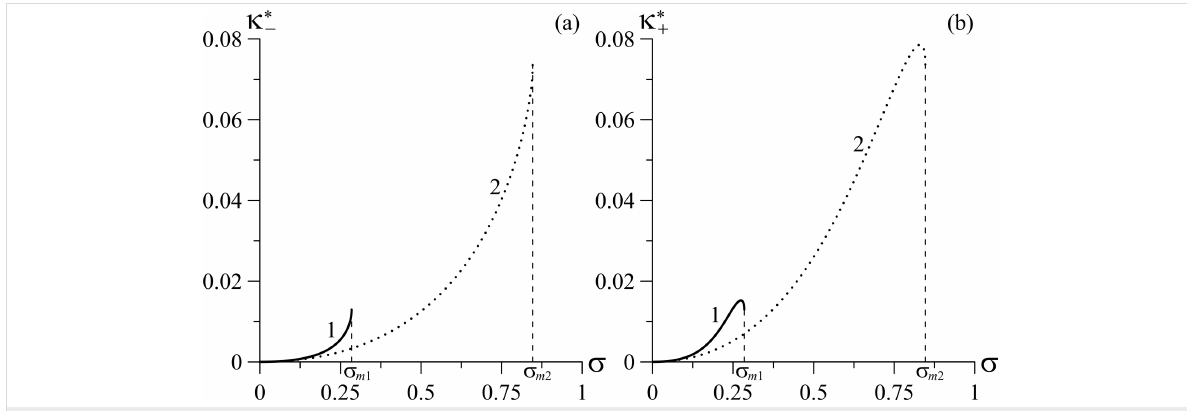
Figure 5: Dependence of the tricritical segregation parameters (a) and (b) on the coupling energy of CNTs with the LC matrix, σ , for different values of the parameter γ for k = 1.5: curve 1 – γ = 0.1, σ m 1 = 0.285; curve 2 – γ = 0.5, σ m 2 =